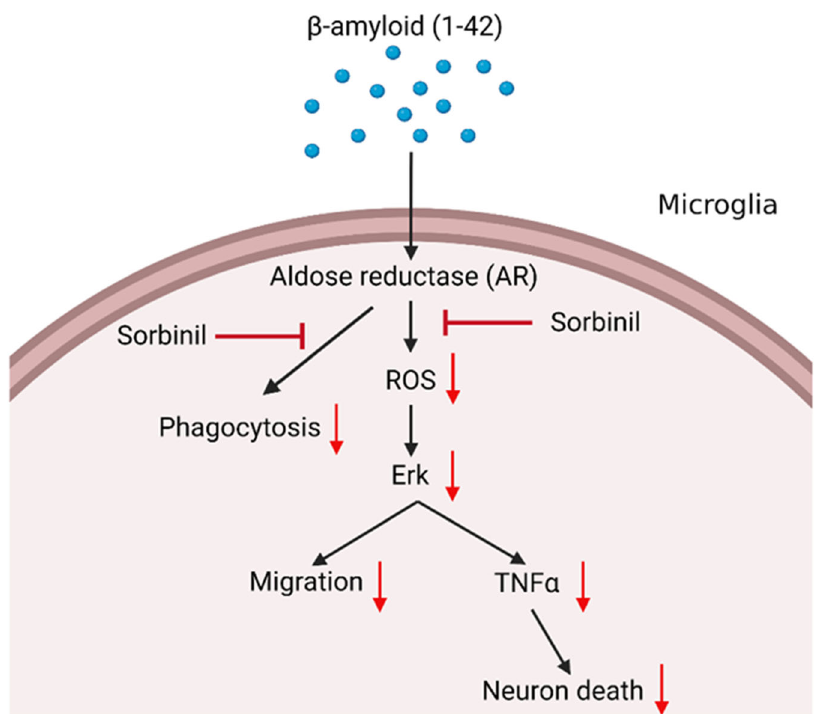
Figure 6. Proposed role of AR in microglia and subsequent neuron death caused by β -amyloid exposure. β -amyloid induces the production of reactive oxygen species (ROS), TNF- α secretion, cell migration, and phagocytosis in microglia. We propose that AR inhibition attenuates the inflammatory responses and prevents neuronal death caused by increased inflammatory cytokine secretion. Red arrows indicate attenuation.